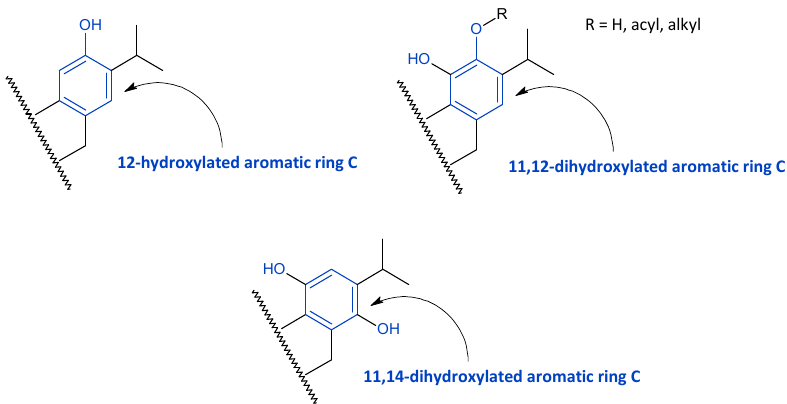
Figure 8. Skeletons of other phenolic abietanes and their substitution with hydroxyl groups. Nineteen compounds of phenolic abietanes (structures 218 – 236 ) are listed in Table 8. They are divided, according to the number and position of hydroxyls at their ring C, into 12-hydroxylated aromatic abietanes (structures 218 – 221 ), 11,12-dihydroxylated aromatic abietanes (structures 222 – 233 ), 11,14-dihydroxylated aromatic abietanes (structures 234 ), and seco -abietanes (structures 235 – 236 ).